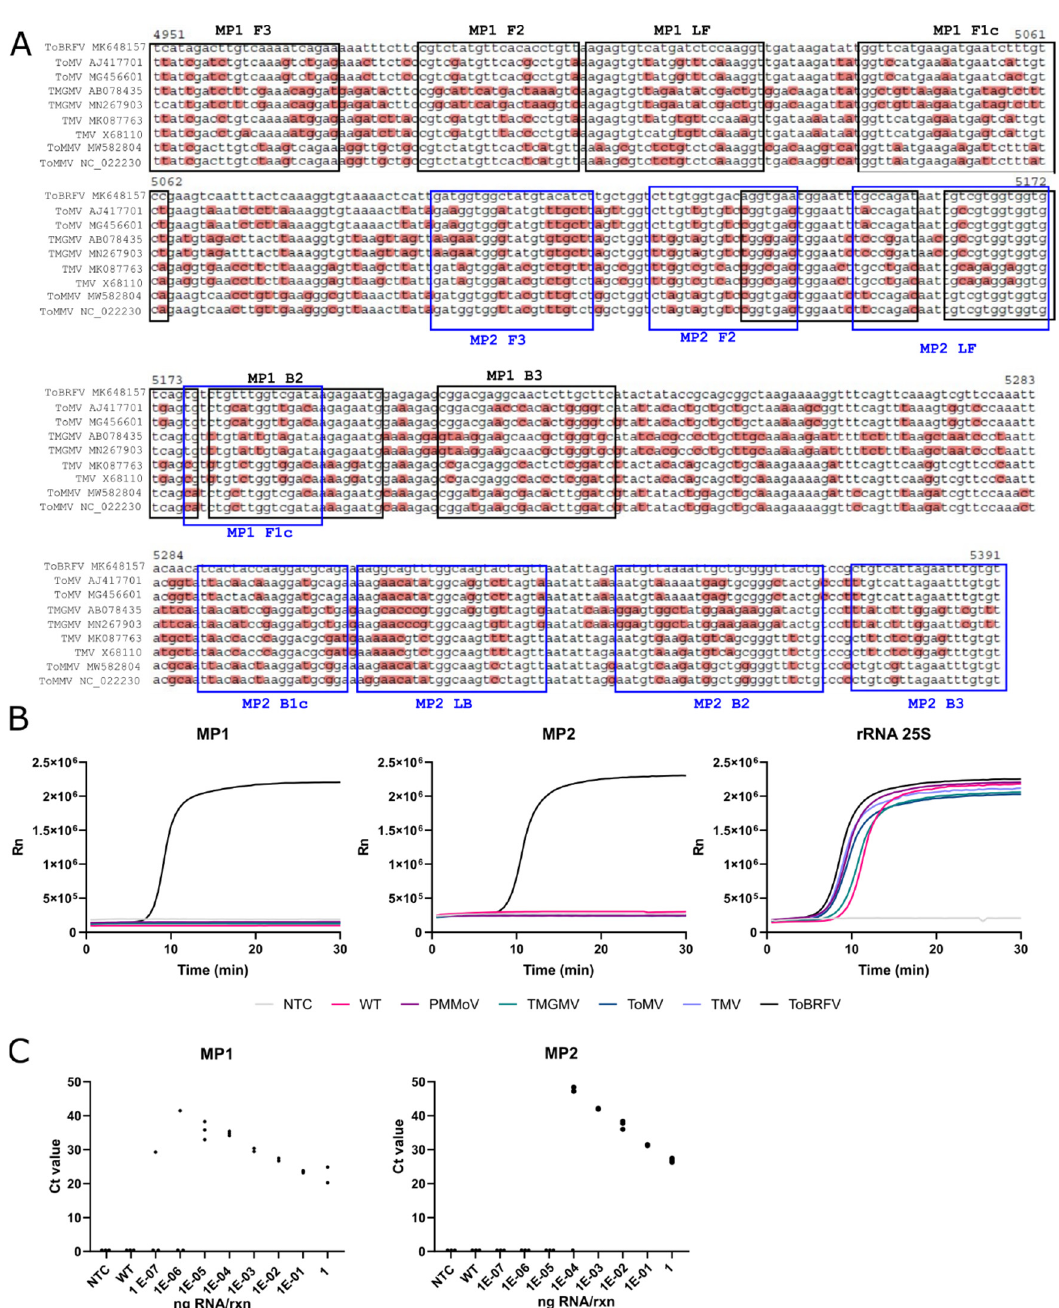
Figure 4. Design and evaluation of an RT-LAMP test for the detection of the ToBRFV MP . ( A ) Two sets of six oligonucleotides each (F3, B3, FIP, BIP, LF, and LB) named MP1 and MP2, were designed for the amplification of two segments of the ToBRFV MP . Black rectangles show the MP1 set and blue rectangles the MP2 oligonucleotides. An additional set of primers was designed to amplify the ribosomal RNA (rRNA) 25S (not shown) as an IC. ( B ) Assessment of the analytical specificity of all the LAMP primer sets using total RNA extracts from healthy or PMMoV-, TMGMV-, ToMV-, TMV- or ToBRFV-infected leaves. ( C ) Analytical sensitivity of the RT-LAMP primer sets MP1, MP2, and rRNA 25S. Individual Ct values for three technical replicates are shown. NTC and healthy plant RNA extract (WT) were used as negative controls. All the dilutions were made using a healthy plant RNA extract as diluent.